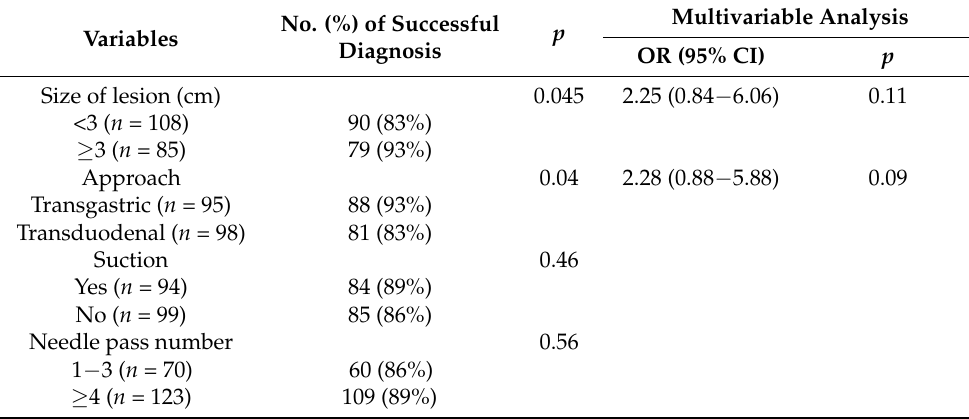
Table 4. Univariable and multivariable analysis about the factors affecting the diagnostic accuracy of EUS-guided fine-needle